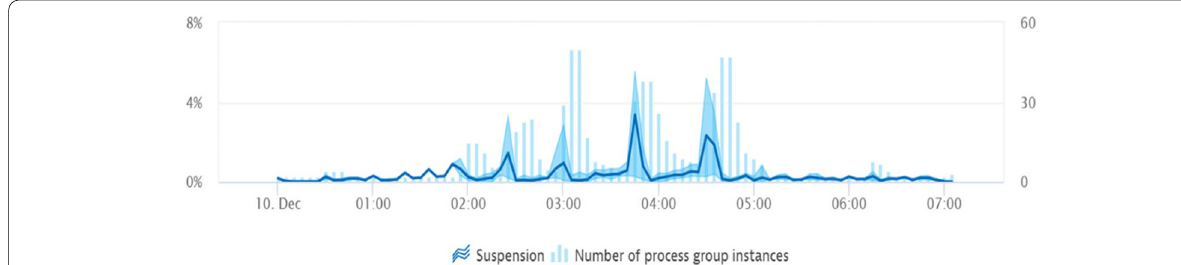
Fig. 25 Suspension % vs. the number of microservice frontend instances